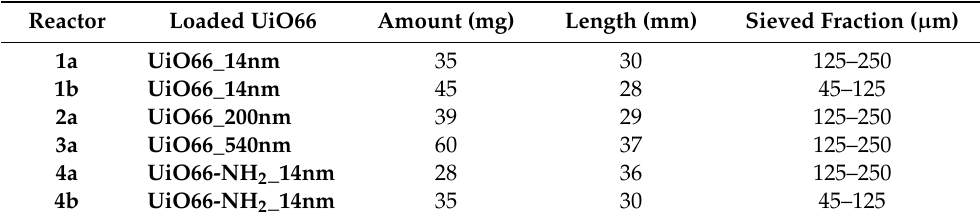
Table 1. Catalyst-loaded capillary reactors used in this